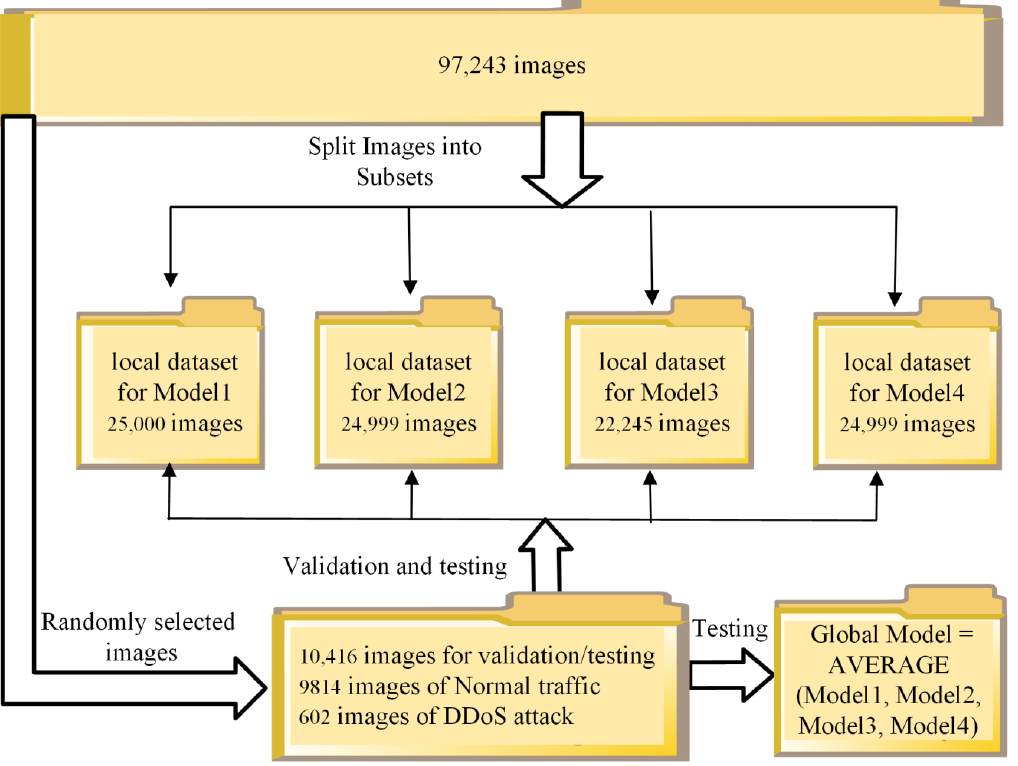
Figure 7. Partitioning of images for FL method simulation.